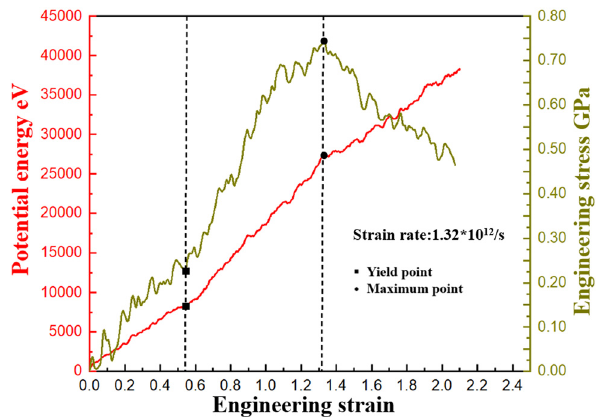
Figure 6: Evolutions of potential energy and stress with straining at a representative strain rate of 1.32 × 10